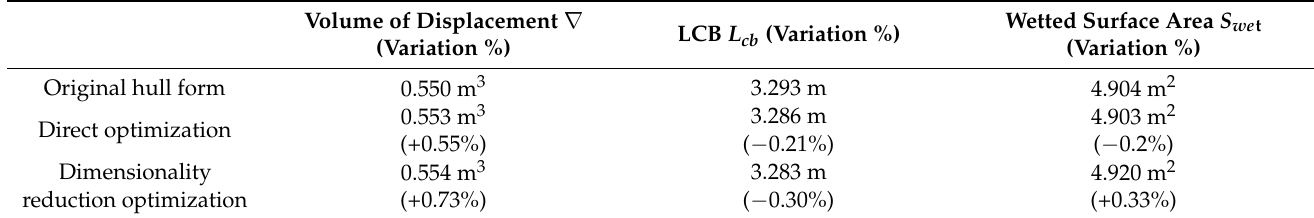
Table 13. Comparison of hydrostatic parameters of three hull